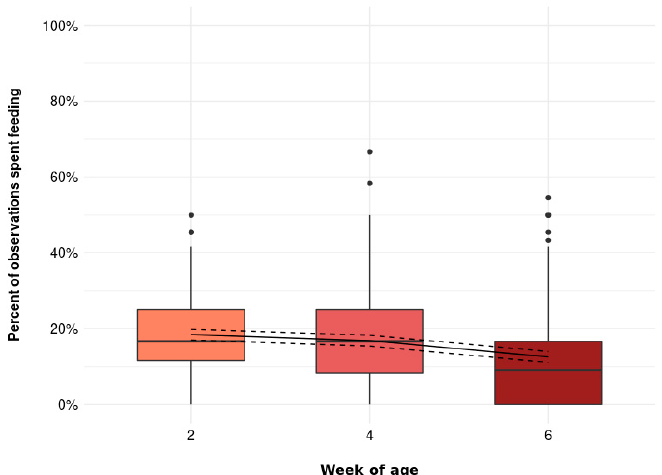
Figure 6. The percentage of observations spent feeding at the feeder at 2, 4, and 6 weeks of age ( p = 0.001). Boxplots show medians, lower, and upper interquartile range of raw data. Whiskers indicate 1.5 times the interquartile range. Solid lines represent estimated means and dashed lines represent 95% confidence intervals.